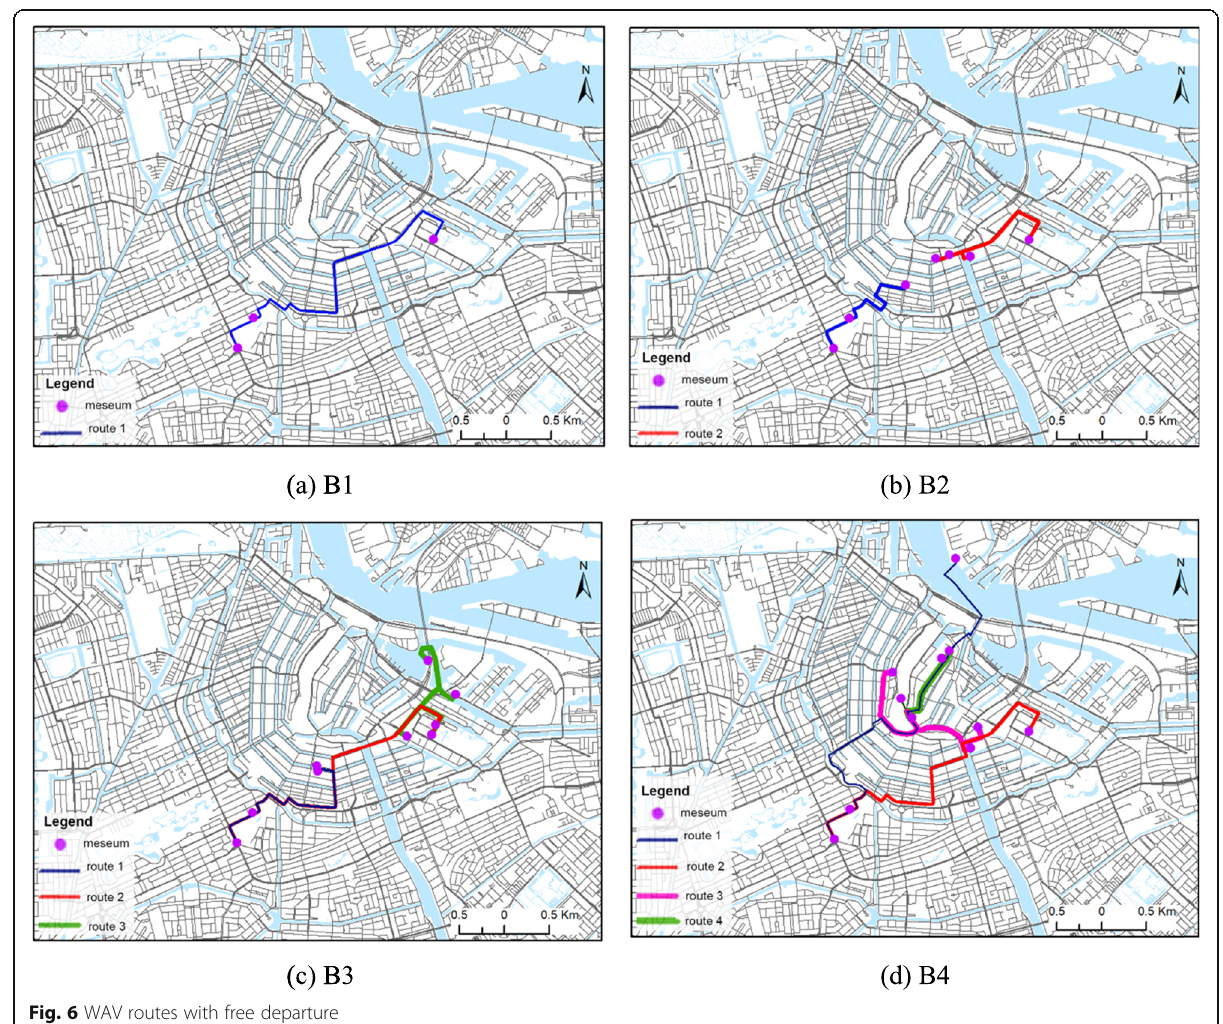
Fig. 6 WAV routes with free departure